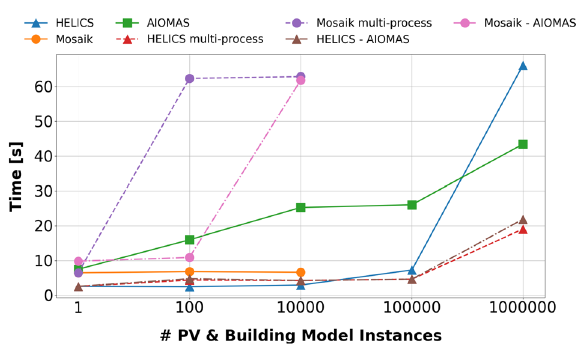
Fig. 8 Setup time duration of the different co-simulation frameworks and their